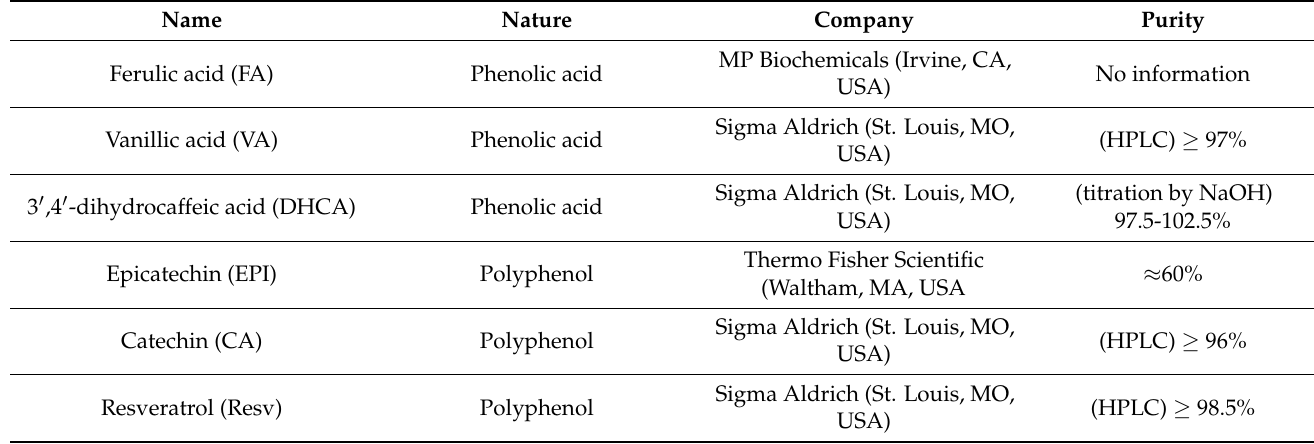
Table 1. Information of polyphenols, including phenolic acids and polyphenol